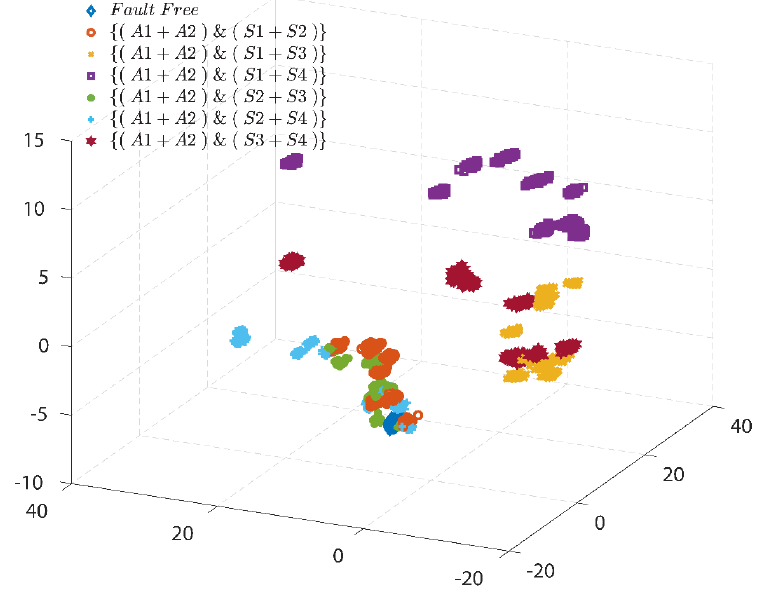
Figure 14. Three-dimensional space visualization performance for fault classification for wind turbines subjected to two actuator and two sensor faults under AWGN noises, using ( a ) MPCA and ( b ) UMPCA, respectively.